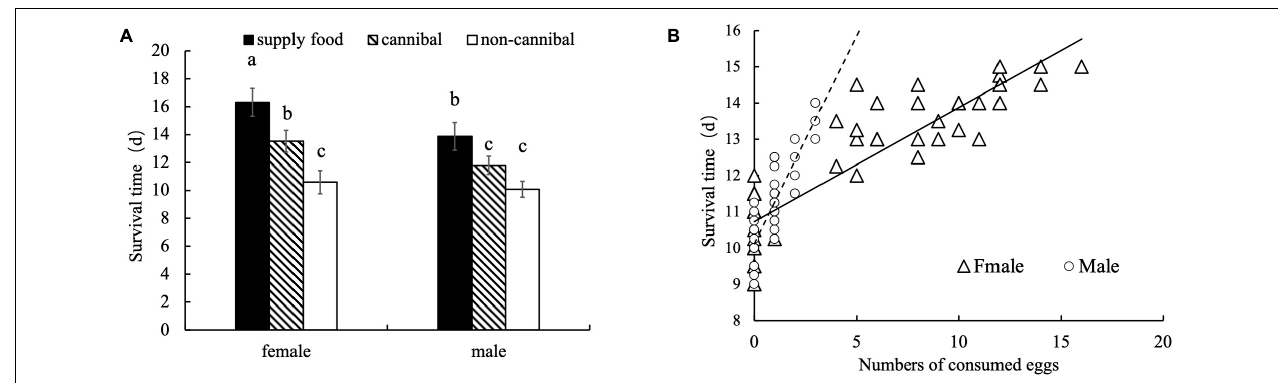
FIGURE 9 | Effect of egg cannibalism on the lifespan of male and female A. custos adults provided with sufficient eggs (number of eggs = 30). Different lowercase letters indicate significant differences ( p < 0.05). Survival time of female and male A. custos adults in supply food, cannibal and non-cannibal conditions (A) . Survival time of female and male A. custos adults as numbers of consumed eggs (B)